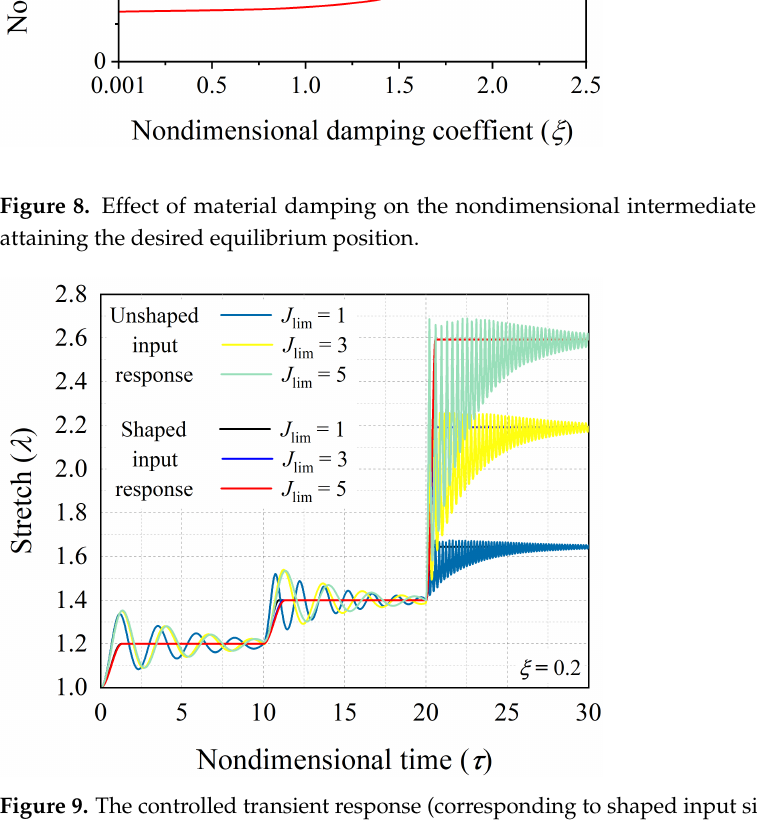
Figure 9. The controlled transient response (corresponding to shaped input signal) and uncontrolled transient response (corresponding to unshaped input signal) of the hard-magnetic soft actuator for different values of J lim (polymer chain extensibility